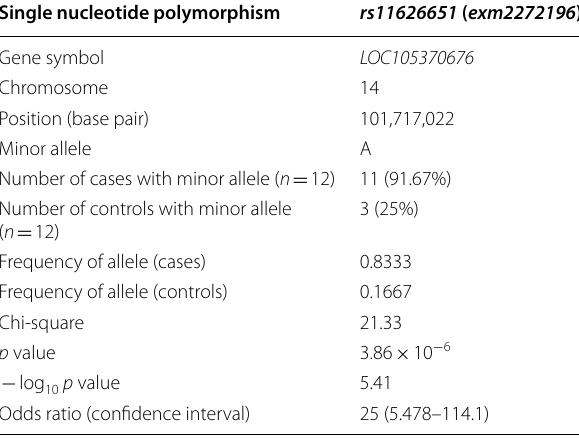
Table 2 The most significant variant retrieved from Manhattan